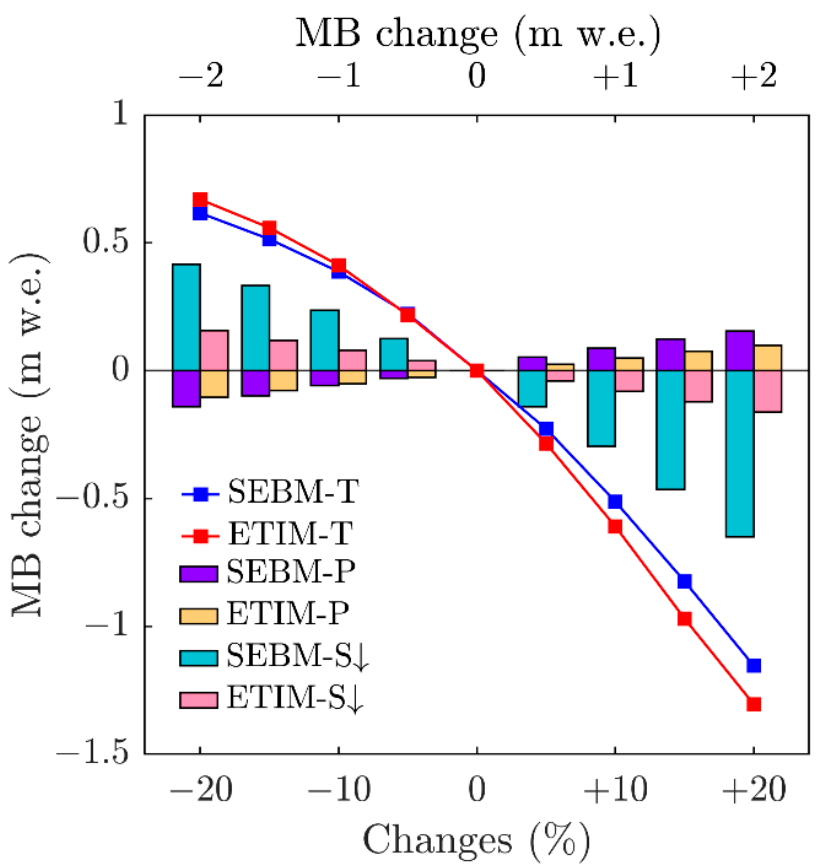
Figure 10. Sensitivities of MB to changes in meteorological elements, including air temperature (T), precipitation (P) and incoming shortwave radiation (S ↓ ).